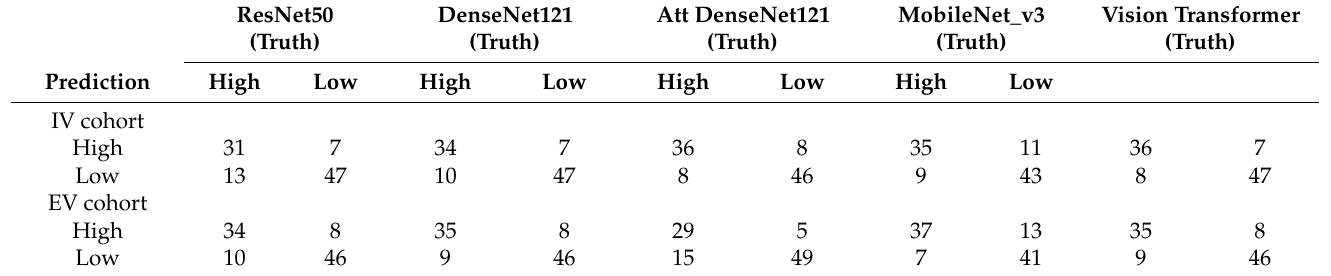
Table 3. Confusion Matrices for attention-based DenseNet121 DL model according to Validation cohorts.